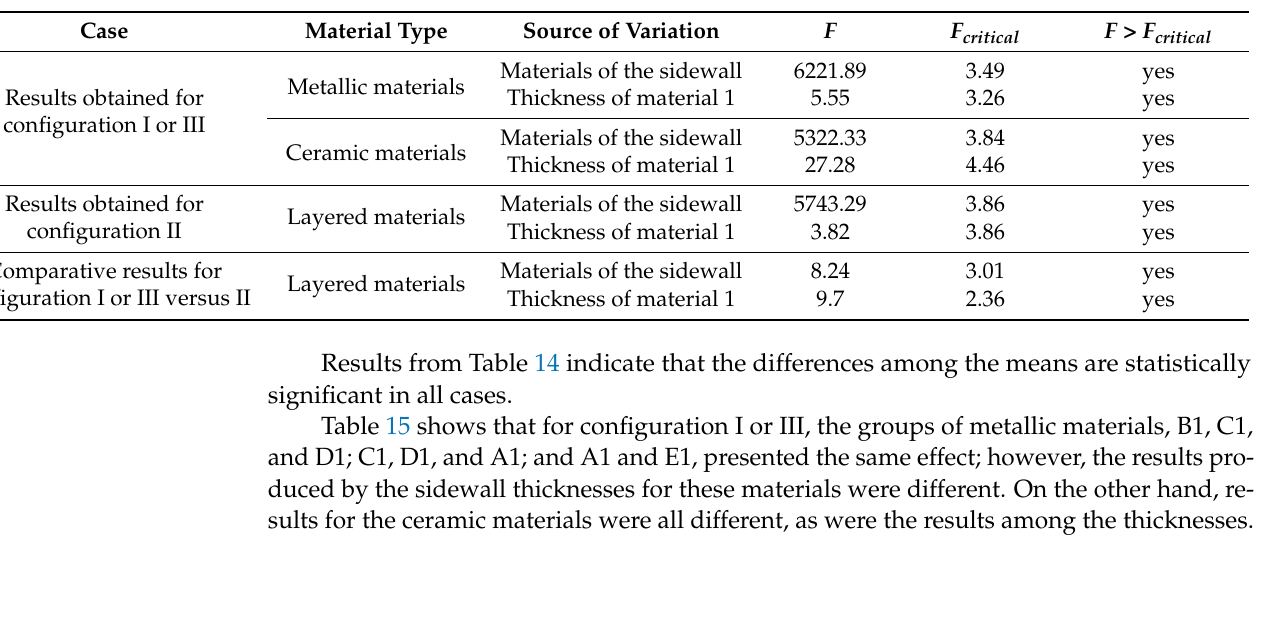
Table 14. Two-way ANOVA applied to the cooling time